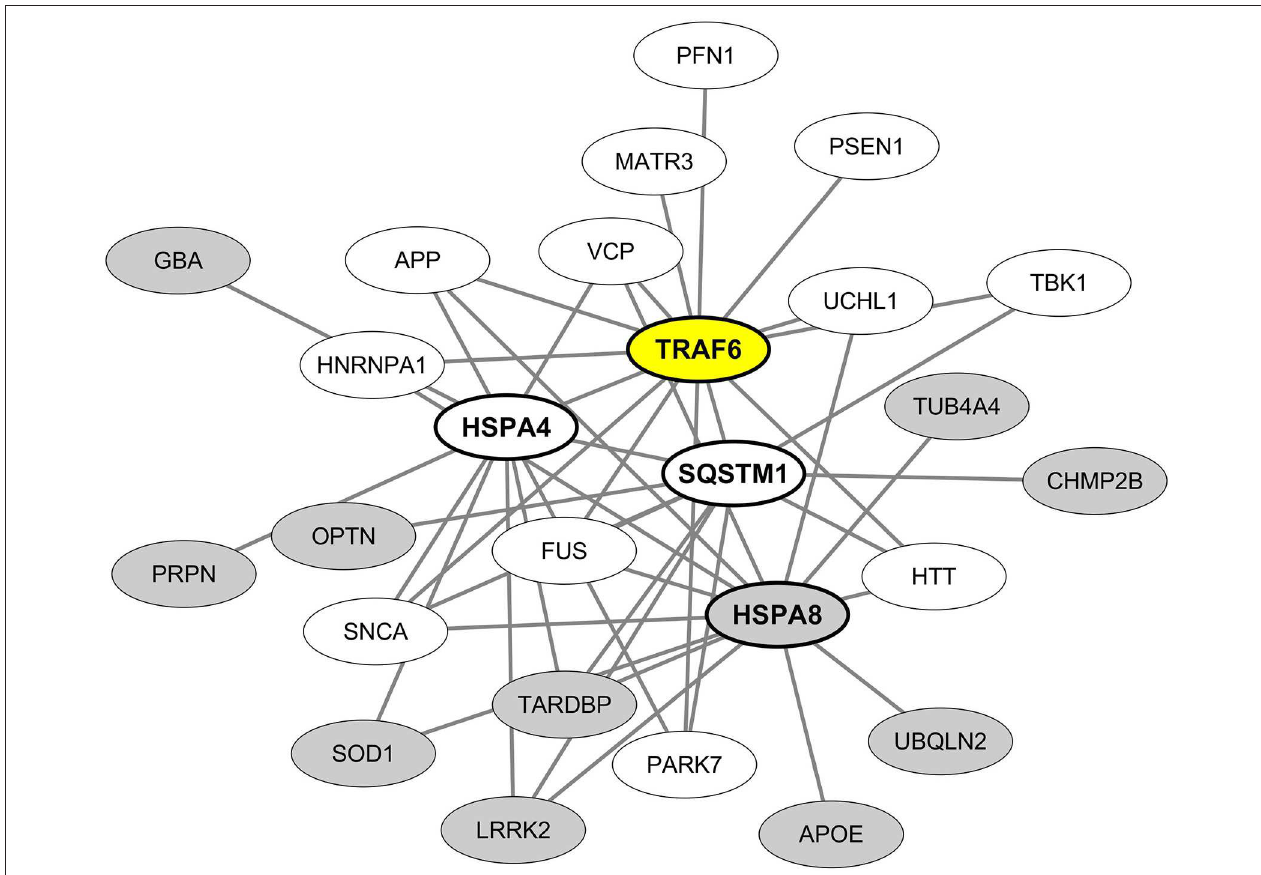
FIGURE 4 | Mapping of the protein-protein interaction network linking common neurodegeneration-associated proteins expressed in B lymphocytes and their hub protein partners. A survey of the human proteome was performed by querying the protein-protein interaction database BioGRID (38). Only proteins expressed by human B lymphocytes according to the “Human Proteome Map” database (39) were taken into account. Each node represents a protein indicated by its corresponding gene symbol. The 4 hub proteins expressed by B lymphocytes and whose partners exhibit the most significant and highest enrichment factors in neurodegeneration-associated proteins are indicated in bold characters. White nodes correspond to neurodegeneration-associated proteins expressed by B lymphocytes and interacting with TRAF6. Gray nodes correspond to common neurodegeneration-associated proteins expressed by B lymphocytes but not reported to interact with